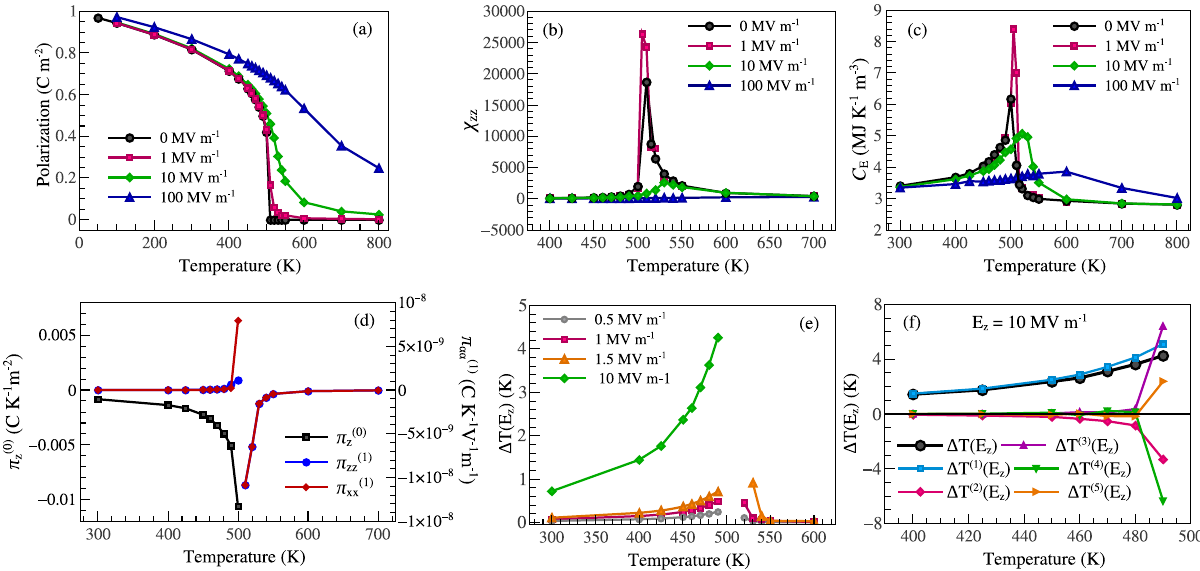
Fig. 1 Simulation results for PbTiO 3 . We show the temperature and fi eld dependence of P ( a ), χ ( b ), and speci fi c heat C E ( c ). d shows the T -dependence of the π ð 0 Þ z , π ð 1 Þ xx , and π ð 1 Þ zz components of the pyroelectric tensors; they correspond to the case in which we have a positive spontaneous polarization along z , as discussed in the text. Also shown is Δ T ( E z ) obtained for different electric fi elds ( e ), as well as the result for E z = 10 MV m − 1 decomposed in the different Δ T ( n ) ( E z ) contributions ( f ). a – c Different colors and symbols are used to represent different values of the applied electric fi eld (black circles for zero fi eld, etc.). d Different colors and symbols correspond to different tensor components (black squares for π ð 0 Þ z , etc.). e Different colors and symbols correspond to different electric fi elds (gray circles for 0.5 MV m − 1 , etc.). f Different colors and symbols correspond to different orders in the applied fi eld (black circles for the total temperature change, blue squares for the term that depends linearly on the fi eld, etc.). e , f No results are shown for T ≳ T C whenever the applied E induces a